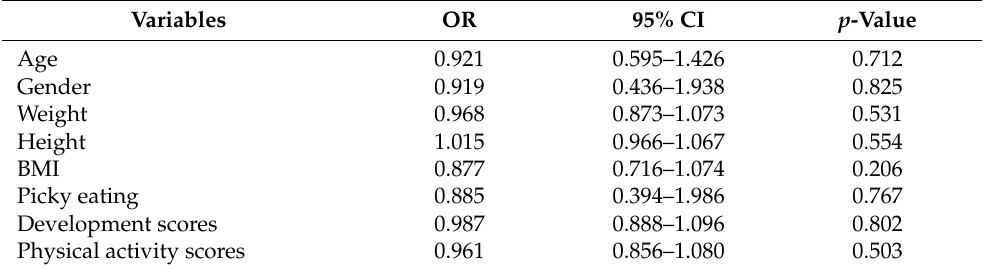
Table 9. Association of iron deficiency with demographics and clinical